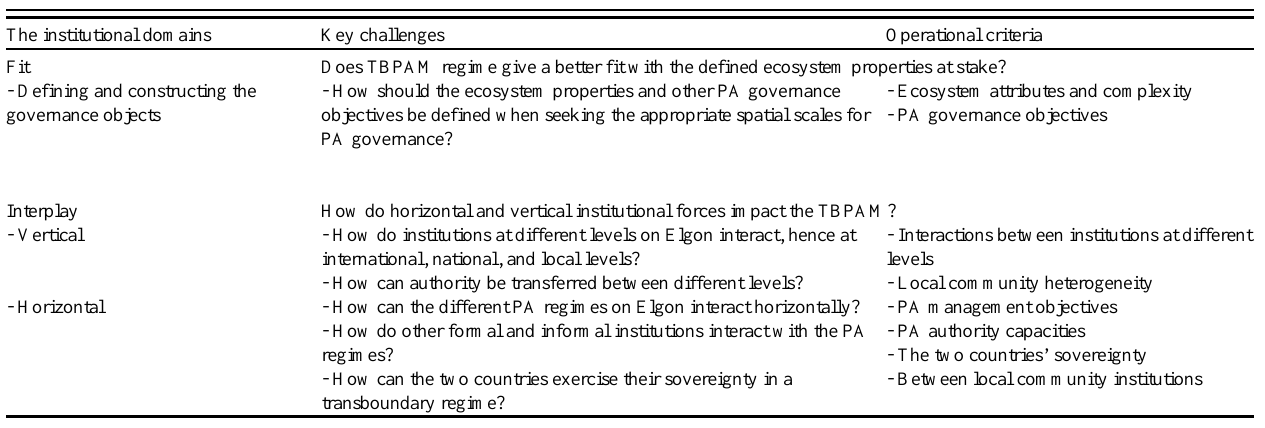
Table 1 . Assessing the overall fitness of a transboundary protected area management (TBPAM) regime: some key challenges. PA = protected